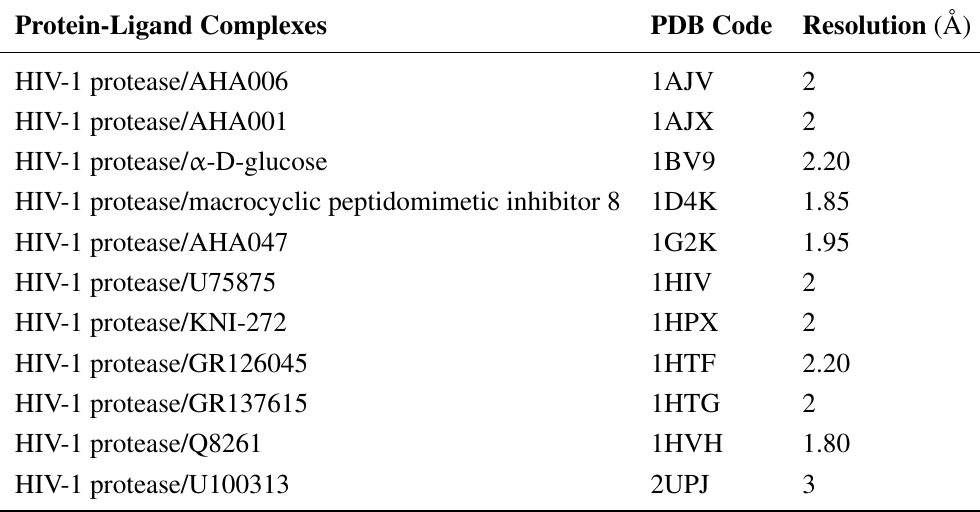
Table 4. X-ray crystal structure coordinates taken from PDB database. Their accession codes from the PDB database and the resolution are also